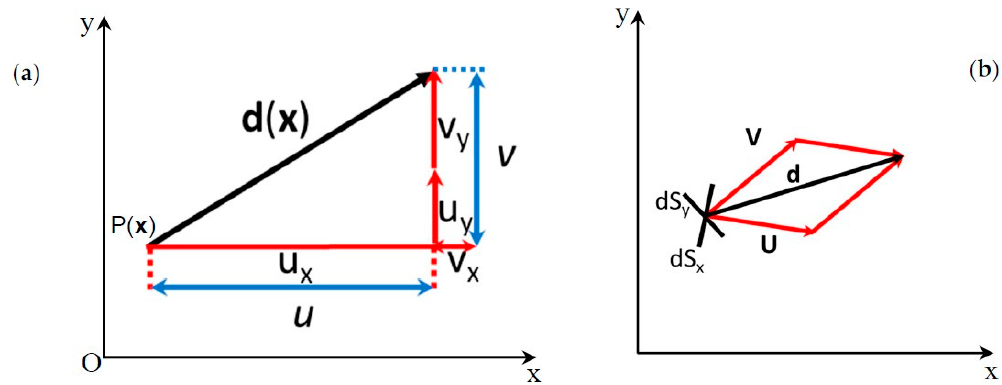
Figure 3. ( a ) Graphical representation of the displacement vector d ( x ) and its projected components u and v ; ( b ) Vectorial sum of the two component vectors.